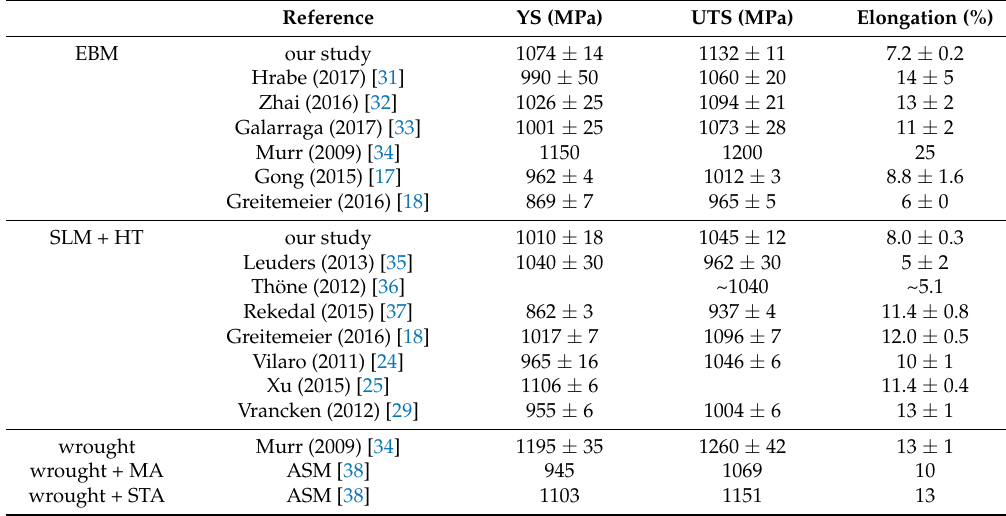
Table 3. Literature review on mechanical properties (YS = yield strength, UTS = ultimate tensile strength) of Ti6Al4V alloy in tension obtained for EBM, SLM followed by heat treatment (HT) and wrought state (MA = mill-annealed, STA = solution-treated +